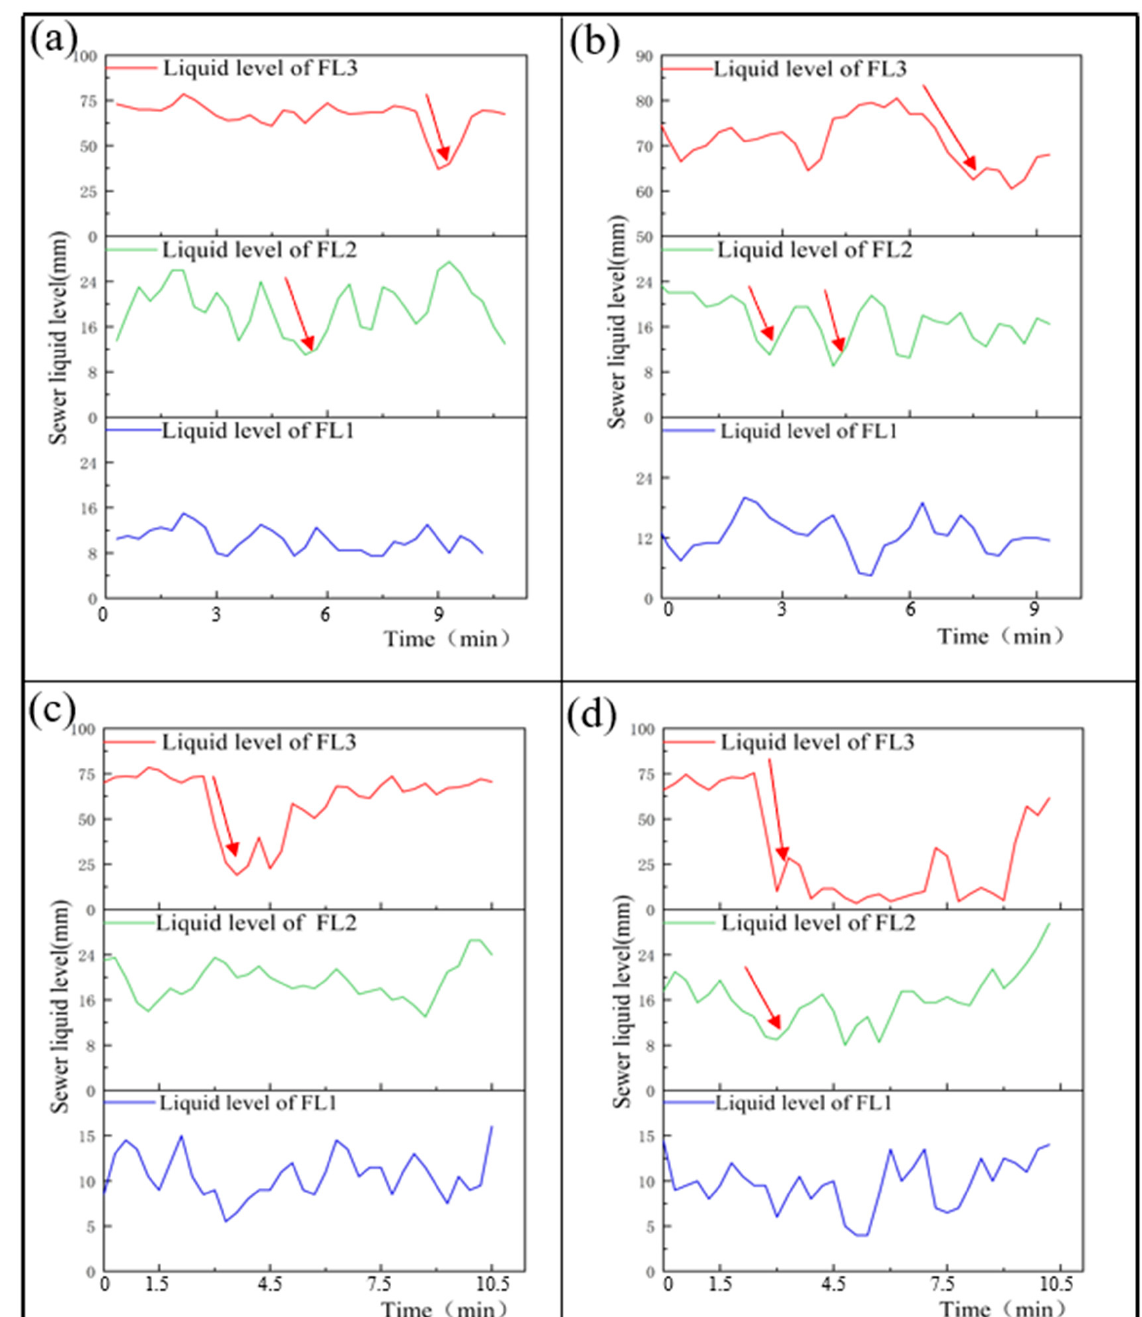
Figure 7. During the low water consumption period, the liquid level change in the upstream and downstream of the DN300 sewer blocking point. ( a ) The upstream and downstream liquid level change of the blocking point when the DN300 sewer was blocked at FW1. ( b ) The upstream and downstream liquid level change of the blocking point when the DN300 sewer was blocked at FW2. ( c ) The upstream and downstream liquid level change of the blocking point when the DN300 sewer was blocked at FW3. ( d ) The upstream and downstream liquid level change of the blocking point when the DN300 sewer was blocked at FW4. The arrows are pointing at when blockage